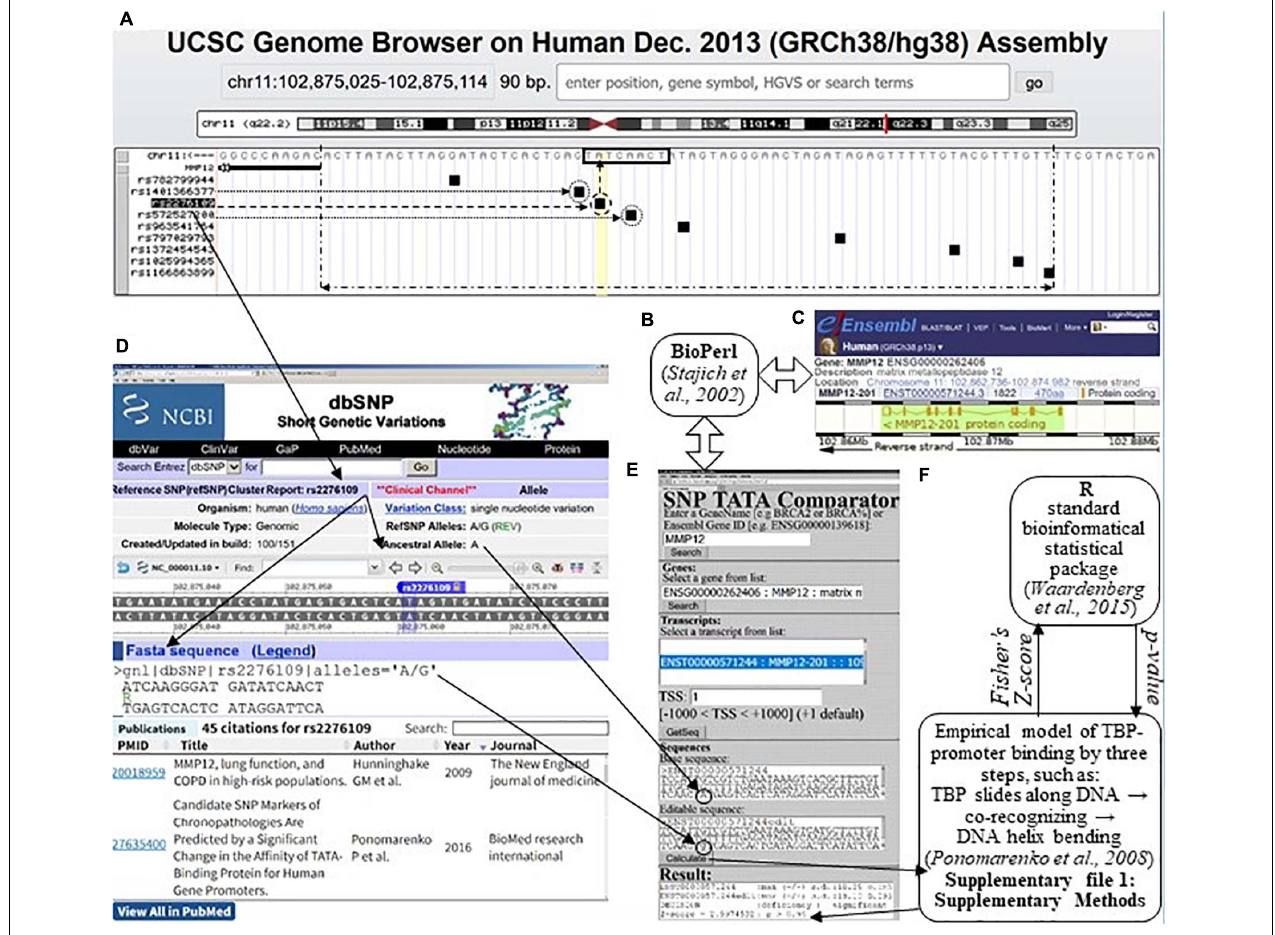
FIGURE 1 | The result produced by SNP_TATA_Comparator (Ponomarenko et al., 2015) in the case of a clinically proven SNP marker (rs2276109) of an asthma risk reduction due to MMP12 downregulation (Hunninghake et al., 2009), which is associated with a reduced risk of rheumatoid arthritis, RA (Liu et al., 2004). (A) The UCSC Genome Browser (Haeussler et al., 2015) visualizes a 70-bp promoter (double-headed dash-and-dot arrow) of a given human gene (here: MMP12, row 2, left column), where there are a TBP-binding site (TBP-site; framed, ) and SNPs retrieved from dbSNP (Day, 2010); their IDs constitute the left-hand column. (B) The Bioperl toolkit (Stajich et al., 2002). (C) The Ensembl database (Zerbino et al., 2015). (D) The current build (No. 151) of the dbSNP database describes the SNP (cid:50) under study (rs2276109 in this example). (E) Our prediction of MMP12 downregulation (textbox “Result”: row 3) caused by SNP rs2276109 (circled) by means of its both alleles (i.e., ancestral and minor ones as input data within two textboxes “Basic sequence” and “Editable sequence,” respectively). Double-headed open arrows ( ⇔ ) depict how SNP_TATA_Comparator retrieved the ancestral DNA sequence of the human MMP12 promoter from the Ensembl database (Zerbino et al., 2015) using the Bioperl toolkit (Stajich et al., 2002). (F) Our bioinformatics model of the TBP-promoter binding via three steps, as follows: (1) TBP sliding along DNA ↔ (2) TBP retarded by the TBP-site ↔ the TBP-promoter complex is fixed due to the bending of the DNA double helix at right angles (Ponomarenko et al., 2008). This model is based on the standard bioinformatical package of R (Waardenberg et al., 2015), as described in Supplementary File 1: Supplementary Methods . Solid arrows: data flows, when one predicts the manifestation of a given SNP using SNP_TATA_Comparator; dashed arrow: the SNP in this example (rs2276109); dotted arrows: two more SNPs, rs572527200 and rs1401366377 ( Figure 3A ), which correspond to either underexpression or overexpression of MMP12 , respectively, as predicted in this work.